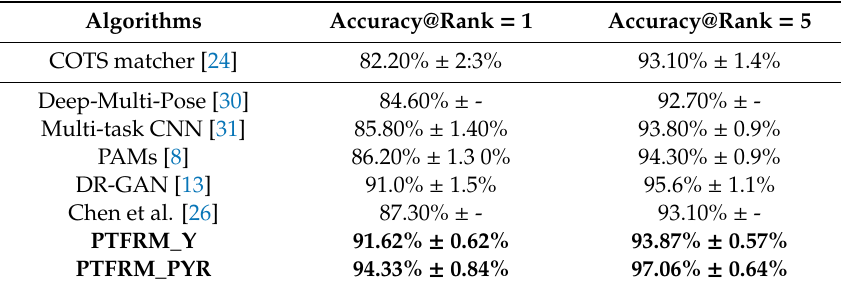
Table 5. Accuracy of related algorithms in face recognition (1:N).